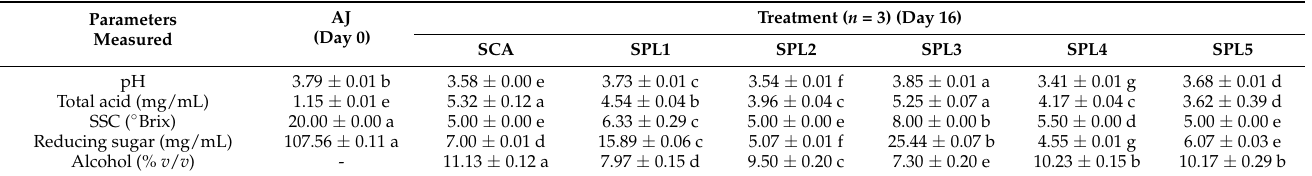
Table 1. Physicochemical parameters determined in the apple juice before inoculation (Day 0) and apple ciders at the end of fermentation (Day